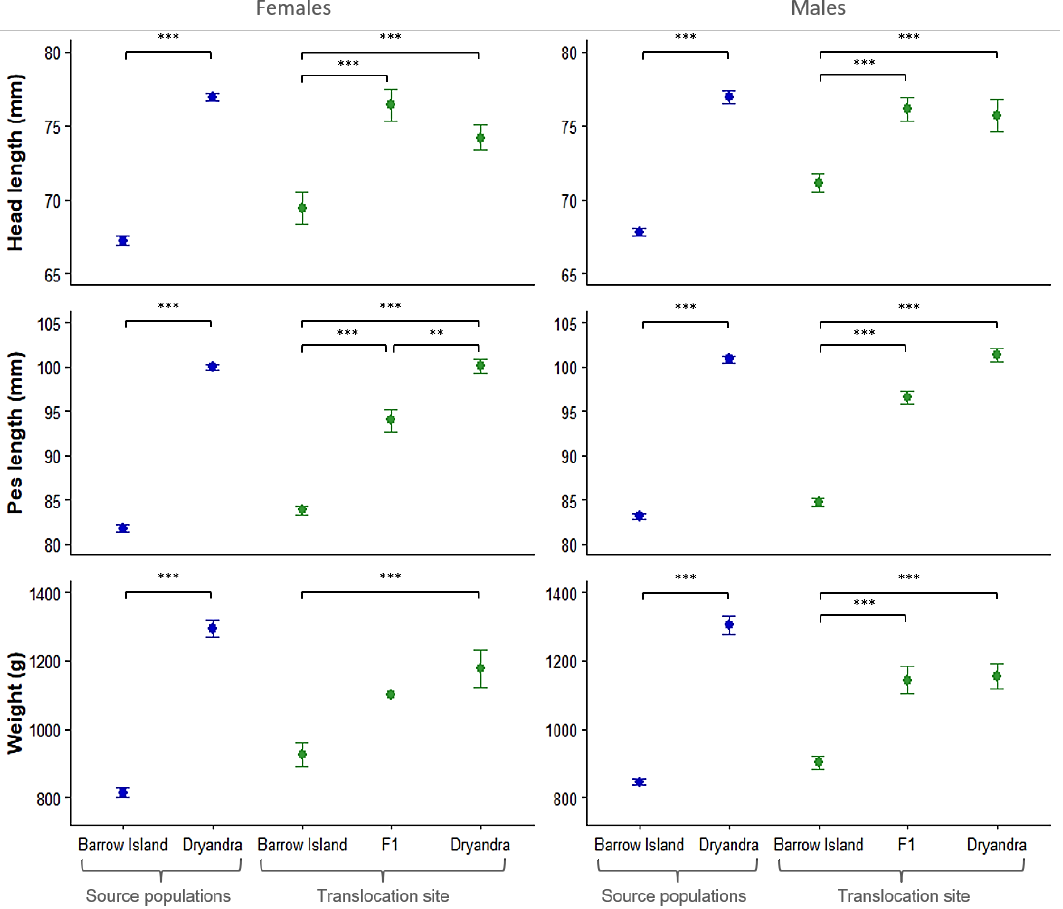
Figure 4. Mean body size in the source populations (blue) and different generations born at the Matuwa translocation site (green). Error bars are standard errors. Significant levels: * P < 0.05; ** P < 0.01; *** P < 0.001.